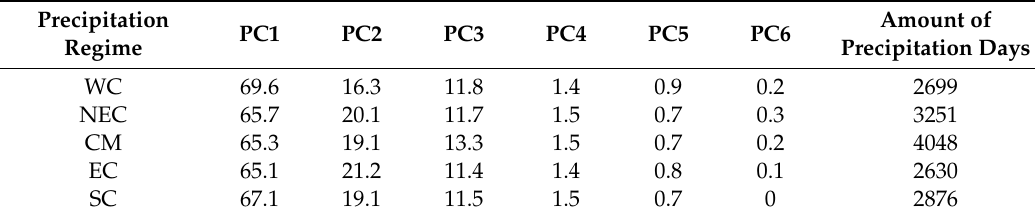
Table 4. Relative distribution of precipitation days (%) on predominant PC patterns and absolute number of precipitation days in the respective precipitation regime.